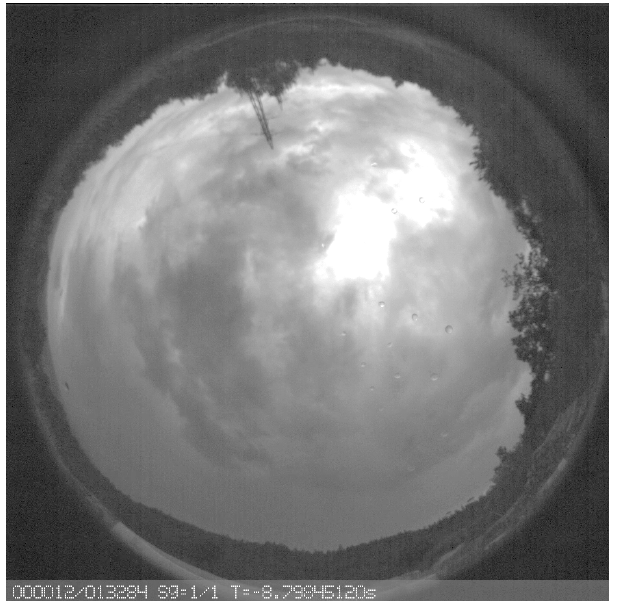
Figure 9. A still-image example from the all-sky camera showing the horizon and the fish-eye lens distortion.